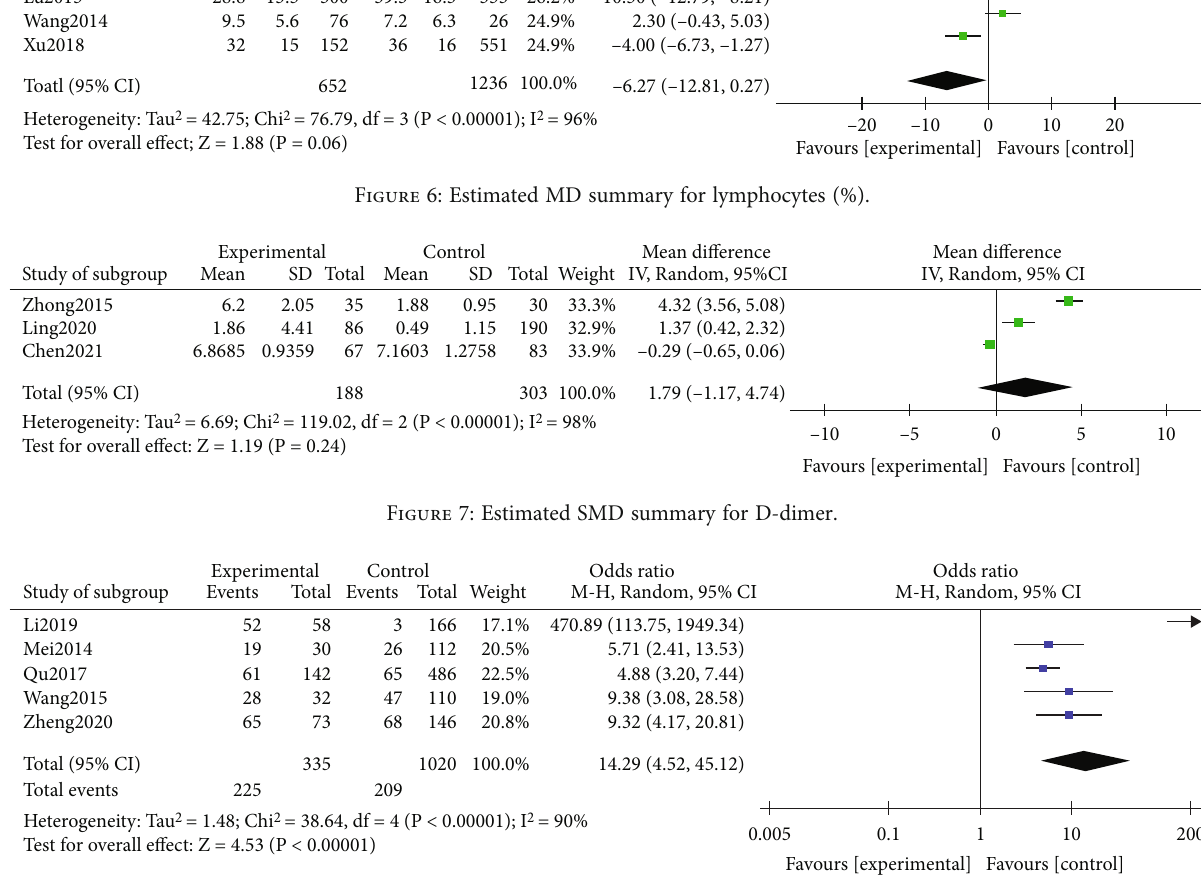
Figure 8: Estimated OR summary for lung